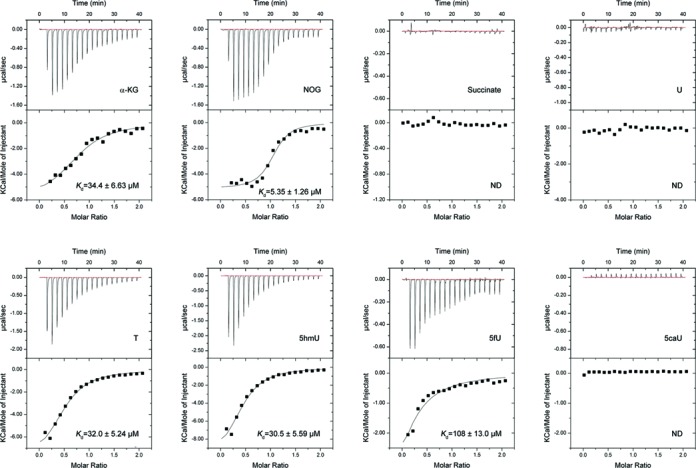
ITC analyses of the binding affinities of NcT7H towards different ligands. The binding affinities of NcT7H for α-KG, NOG and succinate and the binding affinities of NcT7H for U, T, 5hmU, 5fU and 5caU in the presence of NOG were analysed. The dissociation constant (Kd) is indicated. ND, not detected.